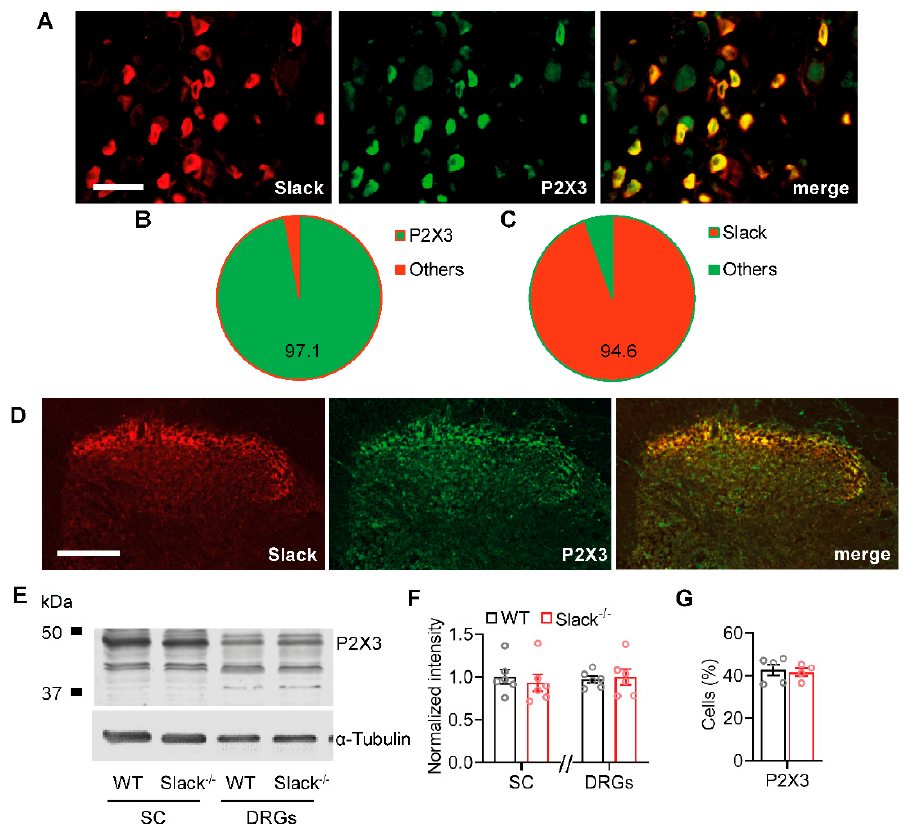
Figure 4. Slack channels co-localize with P2X3 receptors in sensory neurons. ( A – C ) Double-labeling immunostaining of Slack and P2X3 in sensory neurons ( A ) revealed that 97.1% ± 0.2% of Slack- positive DRG neurons co-stained with P2X3 (( B ); 1203 cells counted, n = 3 mice) and that 94.6% ± 2.0% of P2X3-positive DRG neurons co-stained with Slack (( C ); 1203 cells counted, n = 3 mice). ( D ) Double-labeling immunostaining of Slack and P2X3 in the spinal cord indicates a high degree of co-localization in the superficial dorsal horn. ( E , F ) Western blot of P2X3 in spinal cord (SC) and DRGs from WT and Slack -/- mice demonstrates identical abundance of P2X3 in both genotypes. The uncropped original image is shown in Figure S2B. Student’s t-test: p = 0.5986 in the spinal cord and p = 0.7631 in DRGs. Alpha-tubulin was used as a loading control. ( G ) Immunostaining revealed that the percentage of DRG neurons positive for P2X3 is similar in WT and Slack -/- mice. Student’s t-test: p = 0.4046. Bars denote mean ± SEM. Scale bars: 50 µm ( A ) and 100 µm ( D ).